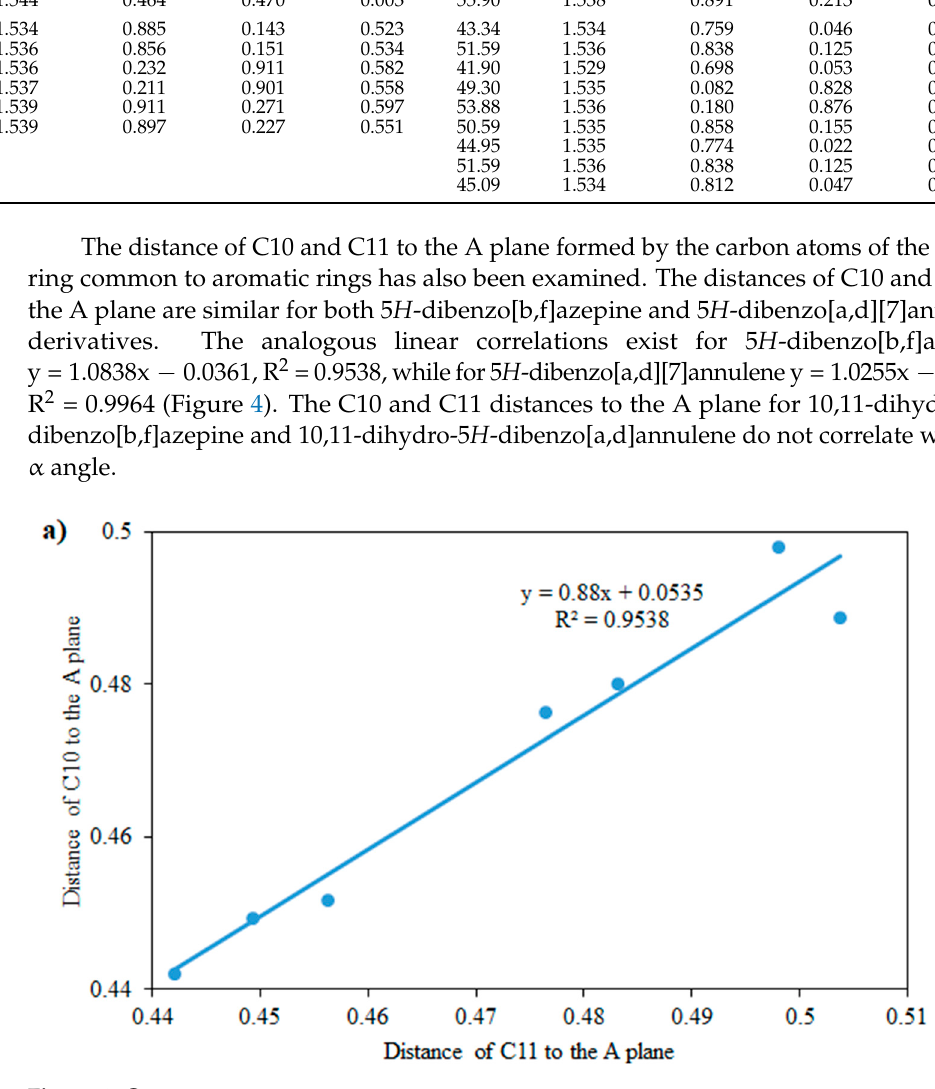
Figure 4. Correlation of C10 and C11 distance to the A plane for 5 H ‐ dibenzo[b,f]azepine ( a ), 5 H ‐ dibenzo[a,d][7]annulenne ( b ). Despite sensitivity of the α angle to substitution of the investigated compounds, the C10C11 bond length changes slightly. The length of the C10C11 double bond in 5 H ‐ dibenzo[b,f]azepine and 5 H ‐ dibenzo[a,d][7]annulene changes from 1.345 Å to 1.352 Å. Larger differences from 1.529 Å to 1.544 Å are observed for the single C10C11 bond in 10,11 ‐ dihydro ‐ 5 H ‐ dibenzo[b,f]azepine and 10,11 ‐ dihydro ‐ 5 H ‐ dibenzo[a,d][7]annulene. In most cases the presence of nitrogen at the 5 ‐ position does not affect the length of the C10C11. All analyzed changes in geometry indicate that the central ring in the investigated compounds is very flexible and may change the geometry from typical for completely aliphatic rings to almost flat. Changes in the geometry of the central ring result from its